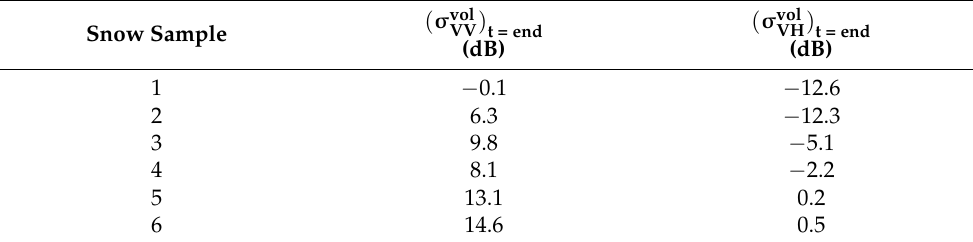
Table 2. Integrated co- and cross-polarized backscatter within the snow sample volume at the final time step of the melt